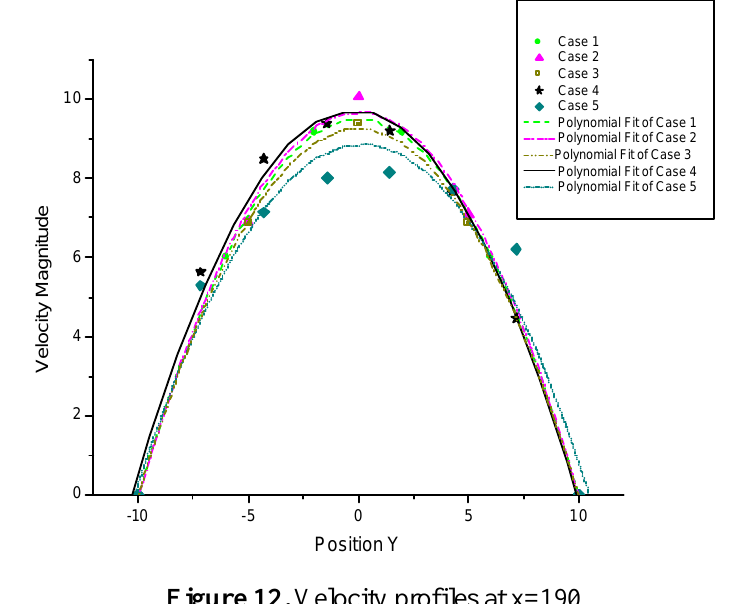
Figure 12. Velocity profiles at